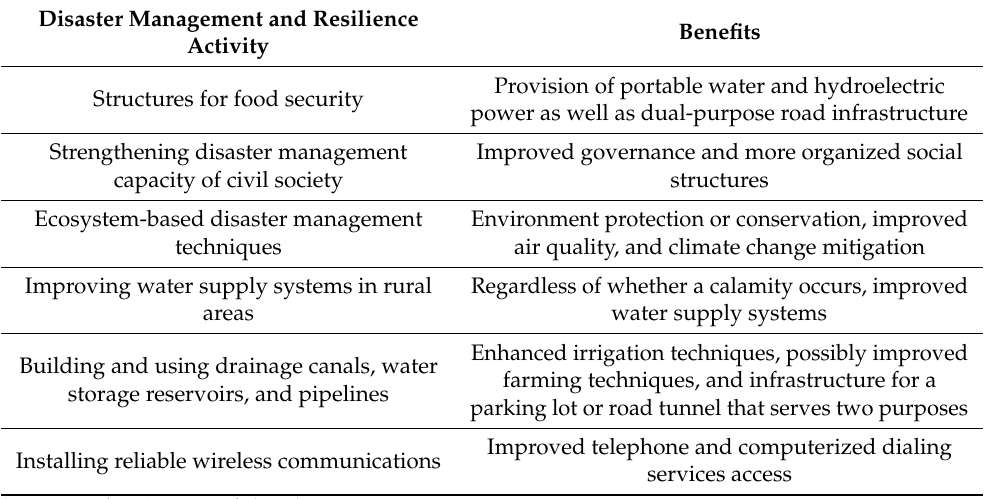
Table 1. Benefits associated with disaster resiliency.